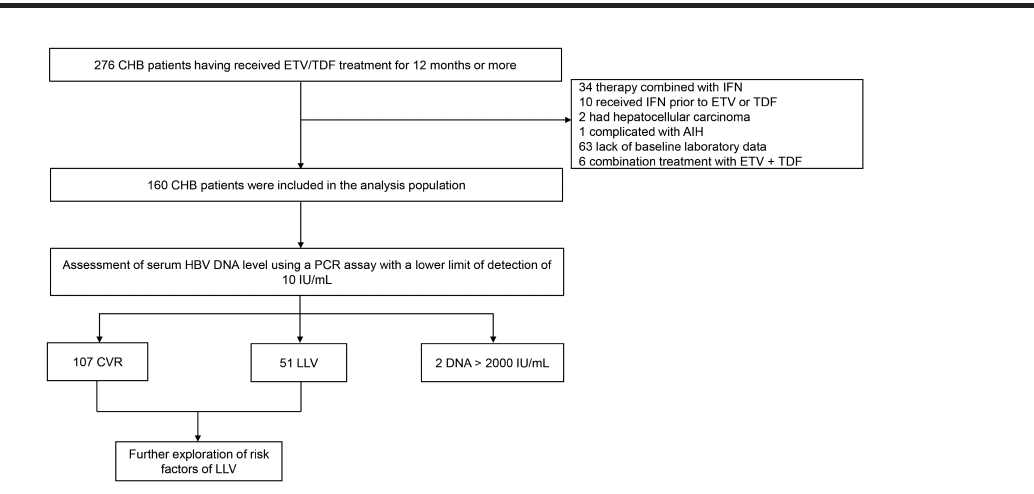
Figure 1. Flowchart of study design. Totally 276 CHB patients who received TDF/ETV treatment for more than 12 months and visited a tertiary hospital in Shanghai, China, between October 2019 and October 2021 were recruited; 116 were excluded. The remaining 160 patients’ serum HBV DNA levels were assessed by a commercially available polymerase chain reaction assay with a lower limit of detection of 10 IU/mL (Abbott, Des Plaines, Ill, USA). 107 patients achieved complete virological response (CVR) with HBV DNA less than 10 IU/mL, 51 patients in a low-level viremia (LLV) state with HBV DNA between 10 IU/mL and 2000 IU/mL, and 2 patients HBV DNA more than 2000 IU/ mL. The patients with CVR and LLV were further studied to explore the risk factors of LLV. CHB, chronic hepatitis B; ETV, entecavir; TDF, tenofovir disoproxil fumarate; CVR, complete virological response; LLV, low-level viremia; IFN, interferon; AIH, autoimmune